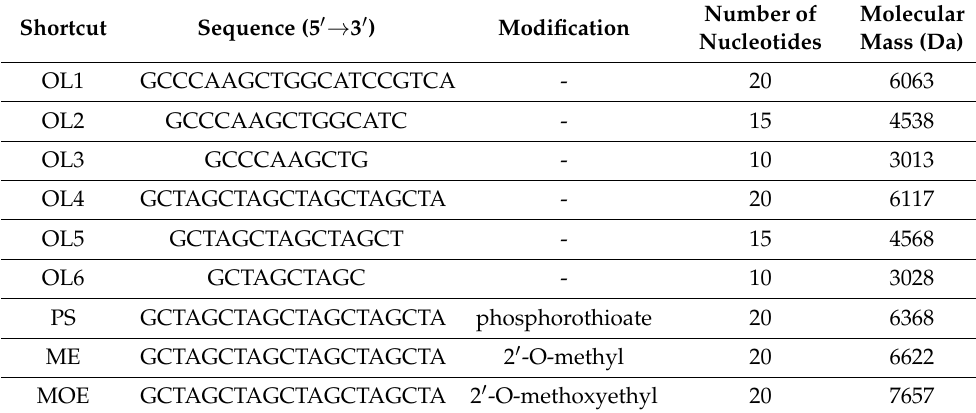
Table 2. Sequences and molecular masses of oligonucleotides used in the present study.